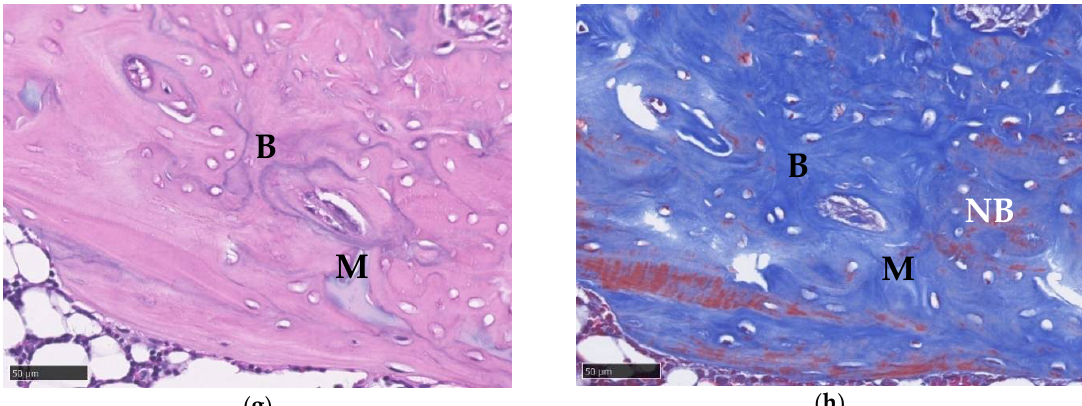
Figure 10. Histological imaging. ( a ) Control group under 10 × magnification view showing a large bone defect filled with fibrotic tissue [F] next to a normal bone structure [B] under H&E. ( b ) Control group with MT staining under 10 × magnification. ( c ) Gel/HA–HAP group under 40 × magnification with H&E staining, residual material [M] can also be observed. ( d ) Gel/HA–HAP group under 40 × magnification with MT staining. Blue stains represent collagen and bone matrix, whereas red stains show cytoplasm and osteoid. Possible new bone [NB] formation can be found near material. ( e ) Gel/HA–HAP–SDF-1 group with H&E staining under 10 × magnification. Residual material was smaller and was well integrated into the normal bone structure. ( f ) Gel/HA–HAP–SDF-1 group with MT staining under 10 × magnification. Some possible new bone formation was also noted. ( g ) Gel/HA–HAP–SDF-1 group with H&E staining under 40 × magnification. ( h ) Gel/HA–HAP–SDF-1 group with MT staining under 40 × magnification.